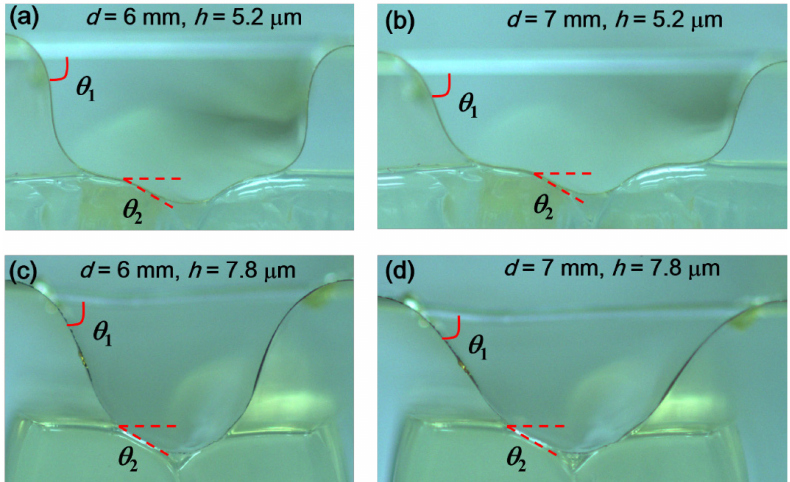
Figure 12. Optical images of the membranes in contact with a surface incorporating a single valley for different deployment factors and normalized lengths.